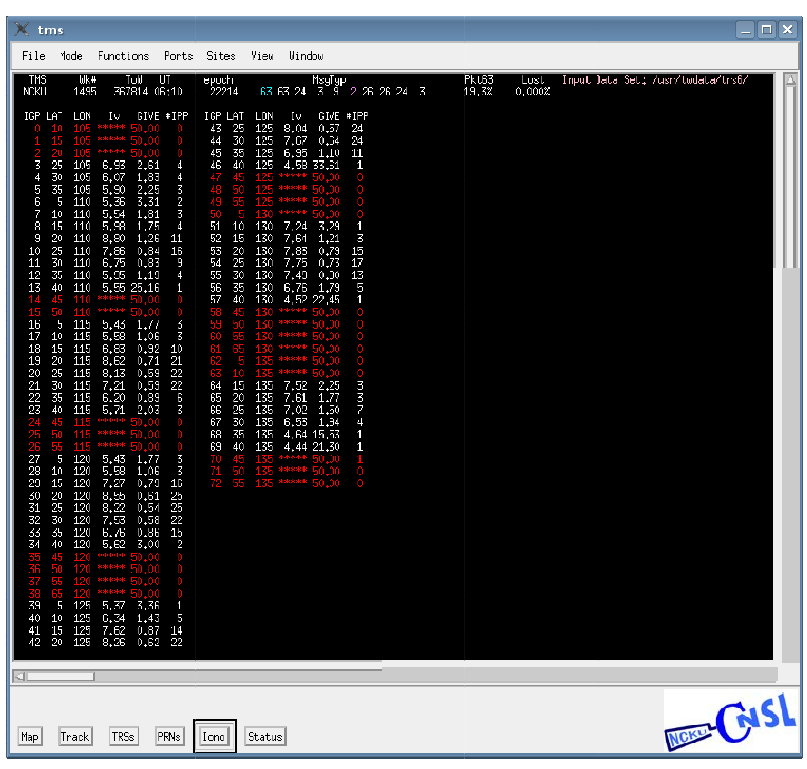
gure 11. The e WADGPS ionS satellites c corrections correctistatus wind dow. e 12. The W WADGPS nospheric g grid ons status w